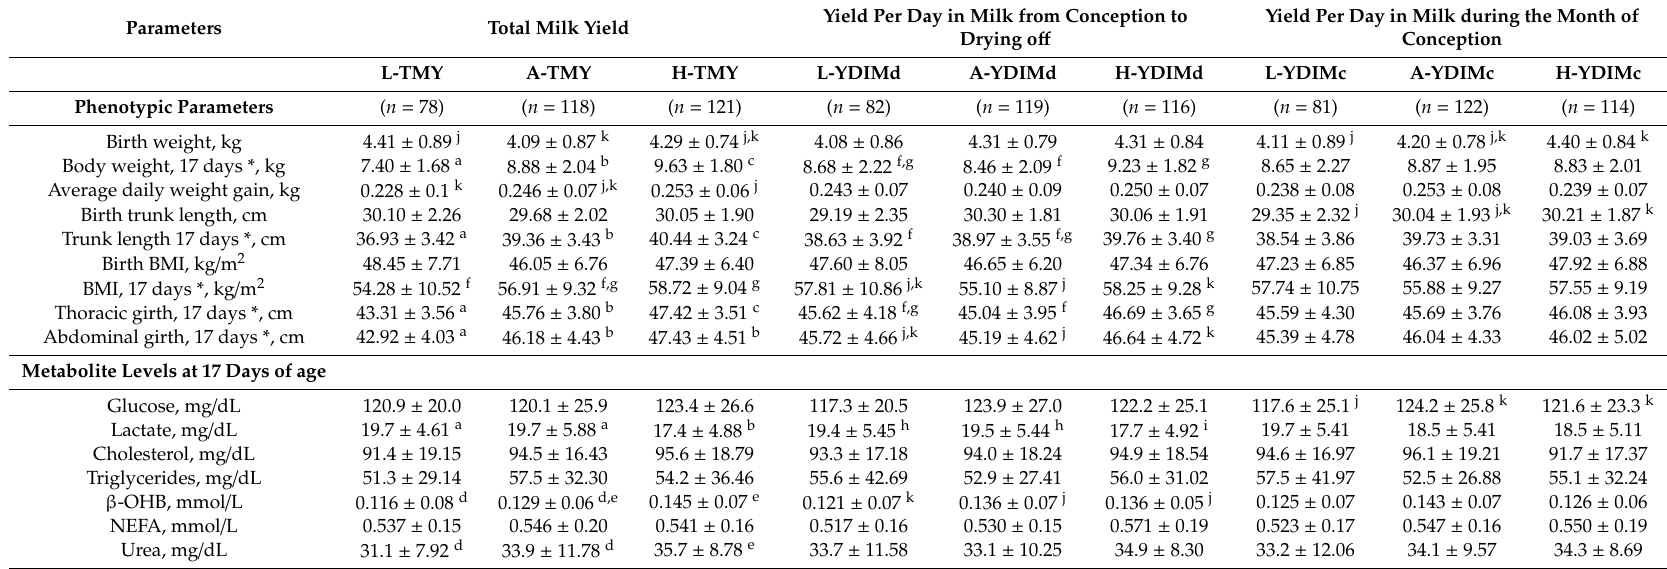
Table 3. Phenotypic parameters and plasma metabolite levels in lambs born to mature ewes showing high, average, or low milk yield during concurrent gestation and